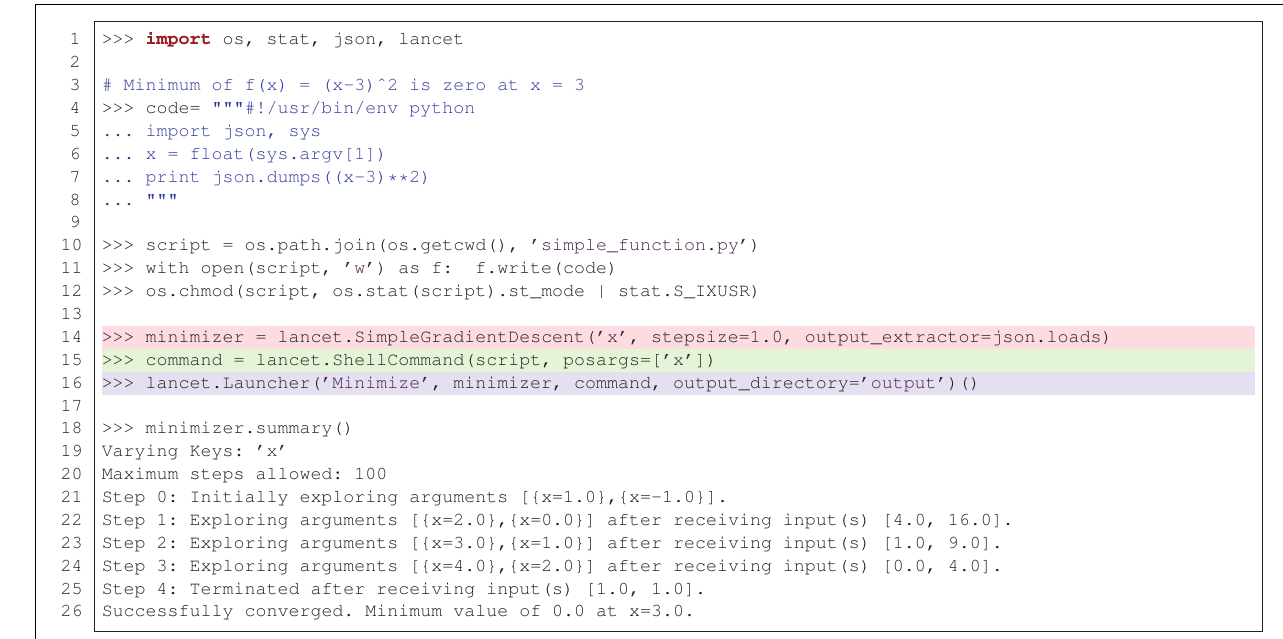
FIGURE 3 | Lancet allows dynamic exploration of parameter spaces using components of type DynamicArguments. In this example, the minimum of f ( x ) = ( x − 3 ) 2 is found using SimpleGradientDescent, starting from x = 0 and terminating at the minimum where x =